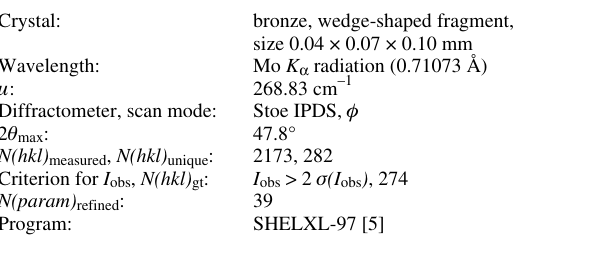
Table 1. Data collection and handling.